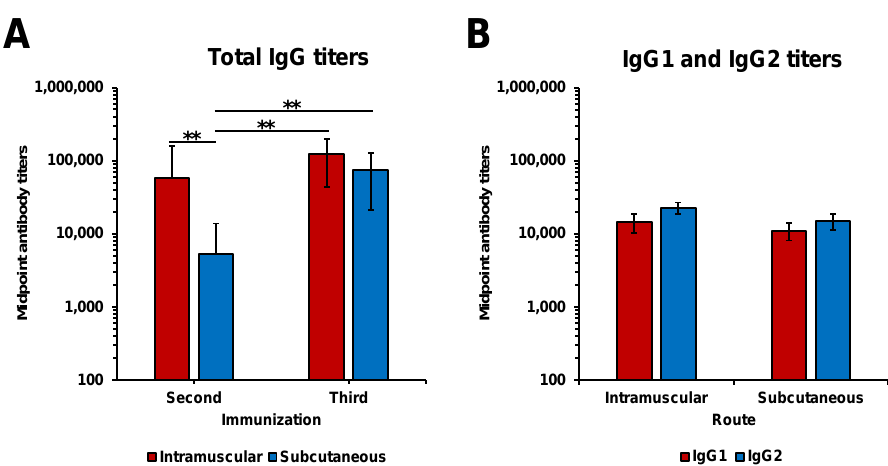
Figure 2. Antibody levels in the vaccinated hamsters. ( A ) Total LigAc-specific IgG titers measured 1 week after the second and the third immunizations. ( B ) Specific IgG1 and IgG2 titers measured at 1 week after the third immunization. The results are shown as mean ± SD. Mann–Whitney U test was used to compare antibody titers or IgG subclasses between groups; ** represents p < 0.01.